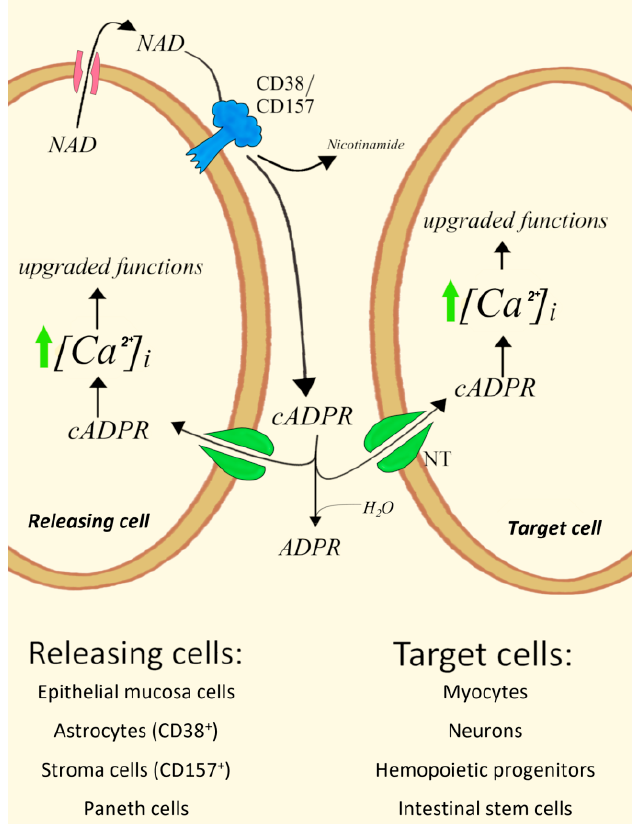
Figure 1. General scheme of cADPR-mediated paracrine interactions between a cADPR-generating and a cADPR-responsive cell. NT, nucleoside transporters.